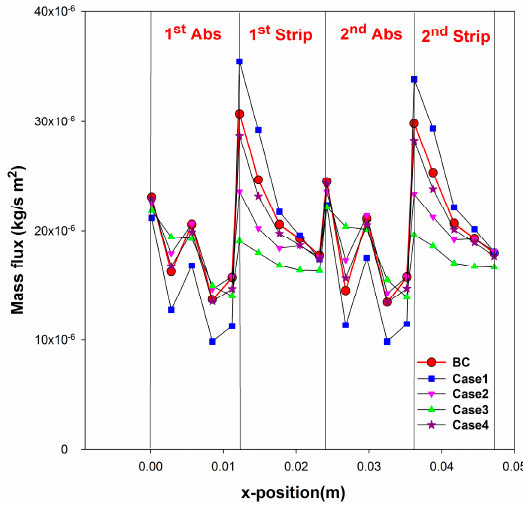
Figure 12. Effect of liquid velocity and diffusivity on mass flux in CS-HASMC (at y = midpoint).